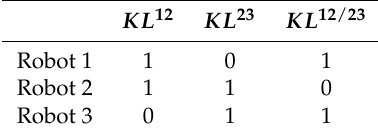
Table 6. The proposed signature matrix of robot 2.